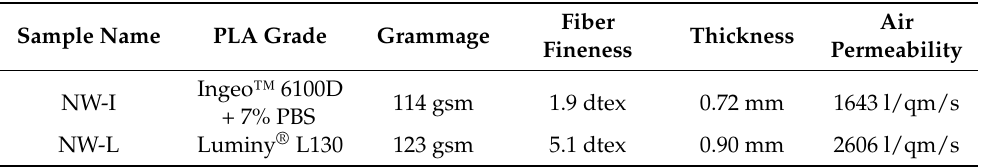
Table 1. Textile-technical parameters of nonwoven fabrics, evaluated according to corresponding